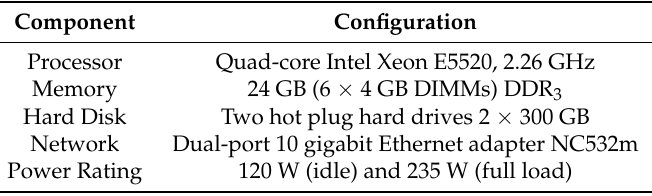
table.html?jumpid=reg_R1002_USEN) was used for energy measurement. It can read real-time